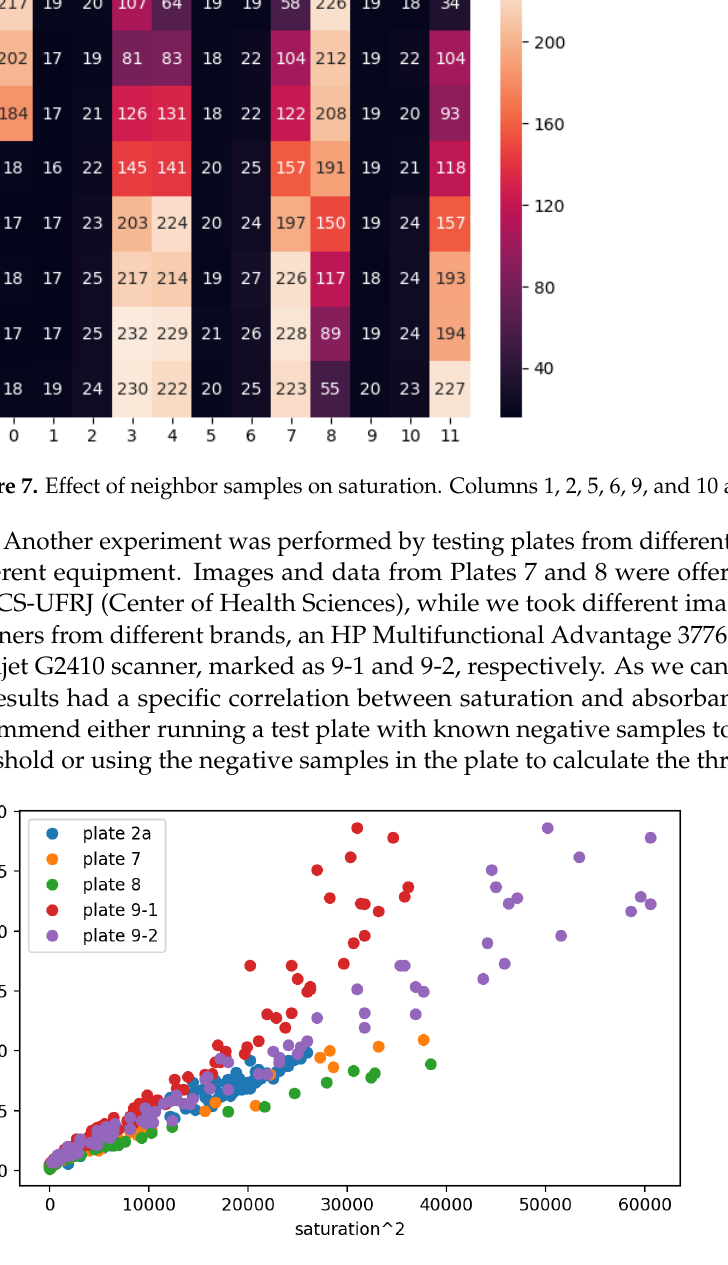
Figure 8. Absorbance vs. squared saturation from images of different sources. Table 3. Comparative results with a spectrophotometer for a set of plates ELISA with Spectrophotometer ELISA with scanner samples, given Equations (1) and (2). The results in terms of the accuracy of the plates with samples whose status is known are given in Table 3. As can be seen, the accuracy, sensitivity, and specificity were at the same level as the ELISA test performed with a